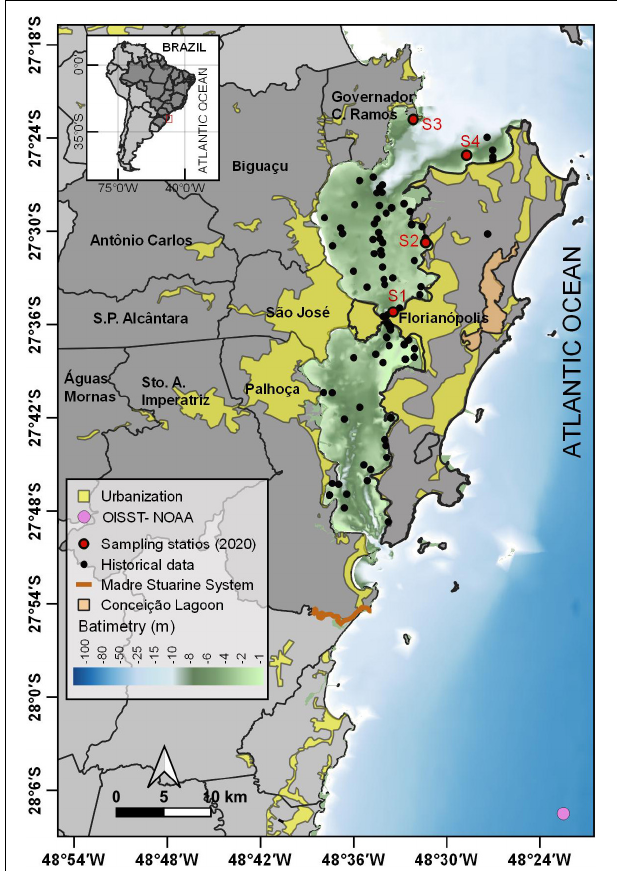
FIGURE 1 | Bay of Santa Catarina Island off Brazil showing coastal water sampling points (black and red circles) and urbanized areas (yellow). The pink circle represents NOAA–OISST: the Optimum Interpolation Sea Surface Temperature from the National Oceanic and Atmospheric